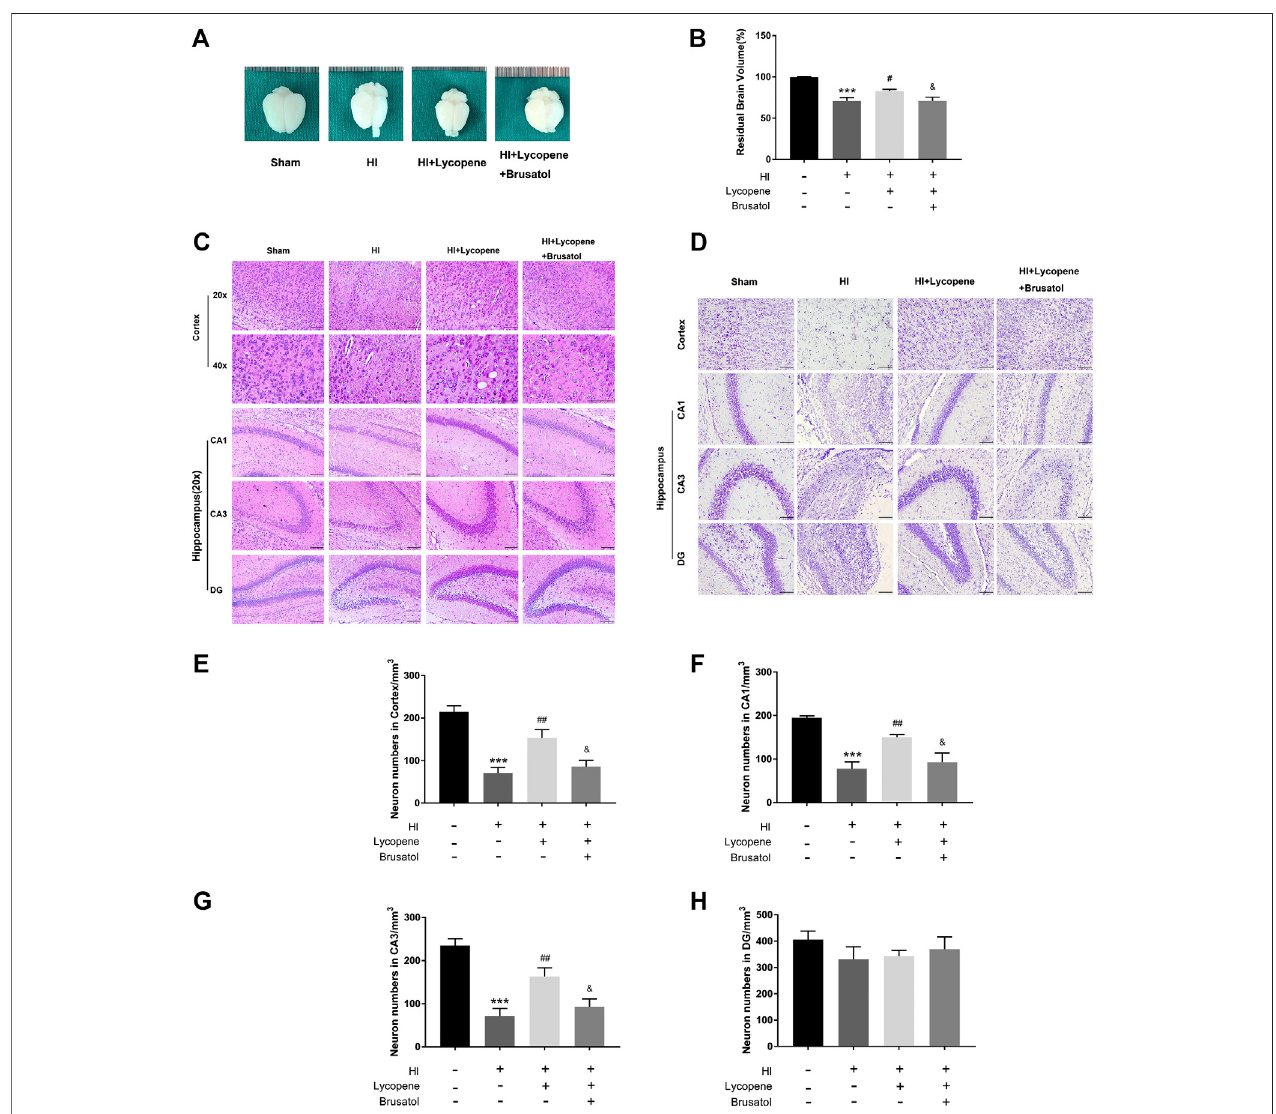
FIGURE 4 | Brusatol reversed the neuro-protective effect of Lycopene (Lyc) after hypoxic-ischemic (HI) brain injury in neonatal rats. (A) Representative images of the brain from each group 7 days after HI injury. n (cid:2) 6. Scale bar (cid:2) 1 mm. (B) The ratio of the injured hemisphere to contralateral hemisphere is de fi ned as residual brain volume. *** p < 0.001 vs. the sham group. # p < 0.05 vs. the HI group. & p < 0.05 vs. the HI + Lyc group. All data are presented as mean ± SEM, n (cid:2) 6. (C) Representative images of H&E staining in the cortex, hippocampus CA1 region, hippocampus CA3 region and DG region 1 week after HI injury. Scale bars (cid:2) 100 μ m. (D) Representativeimagesandquanti fi cationdata (E – H) ofNisslstaininginthecortex,hippocampusCA1,CA3,DGregion7 daysafterhypoxic-ischemicinjury.Scalebar (cid:2) 100 μ m *** p < 0.001 vs. the sham group; ## p < 0.01 vs. the HI group; & p < 0.05 vs. the HI + Lyc group. All data are presented as mean ± SEM, n (cid:2) 5.